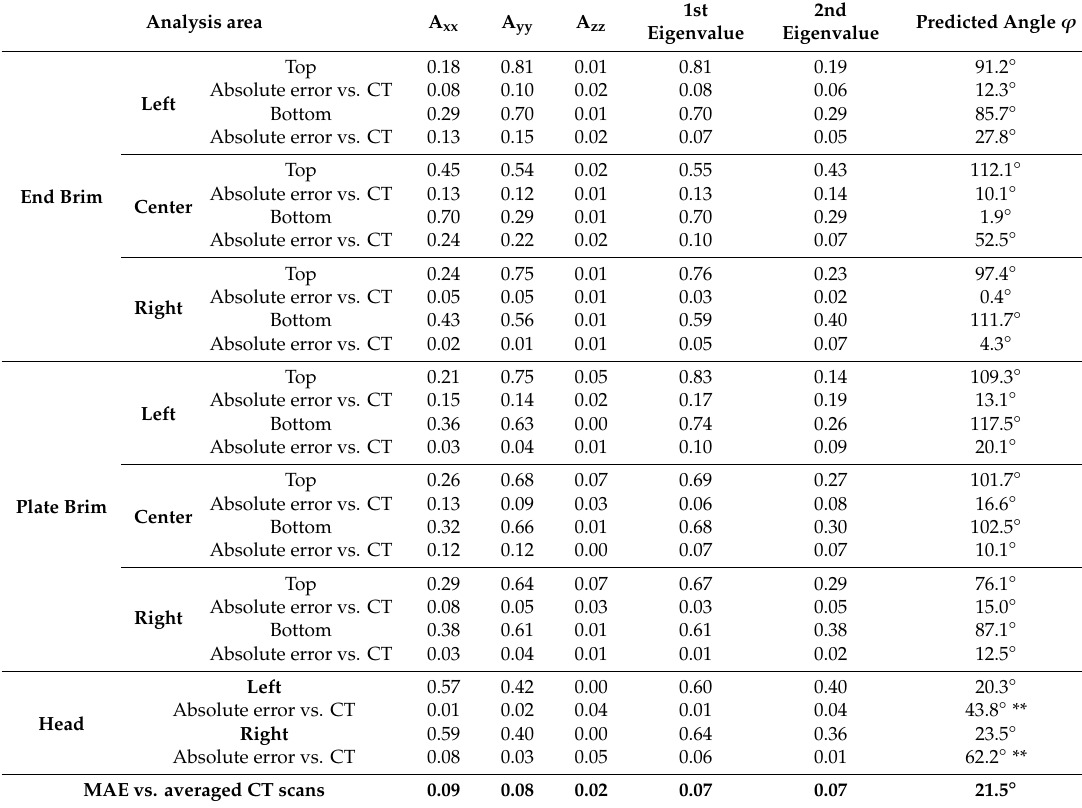
Table 9. Predicted fiber orientation results for the brim and head analysis areas of the ribbed hat profile using 3D TIMON CompositePRESS.